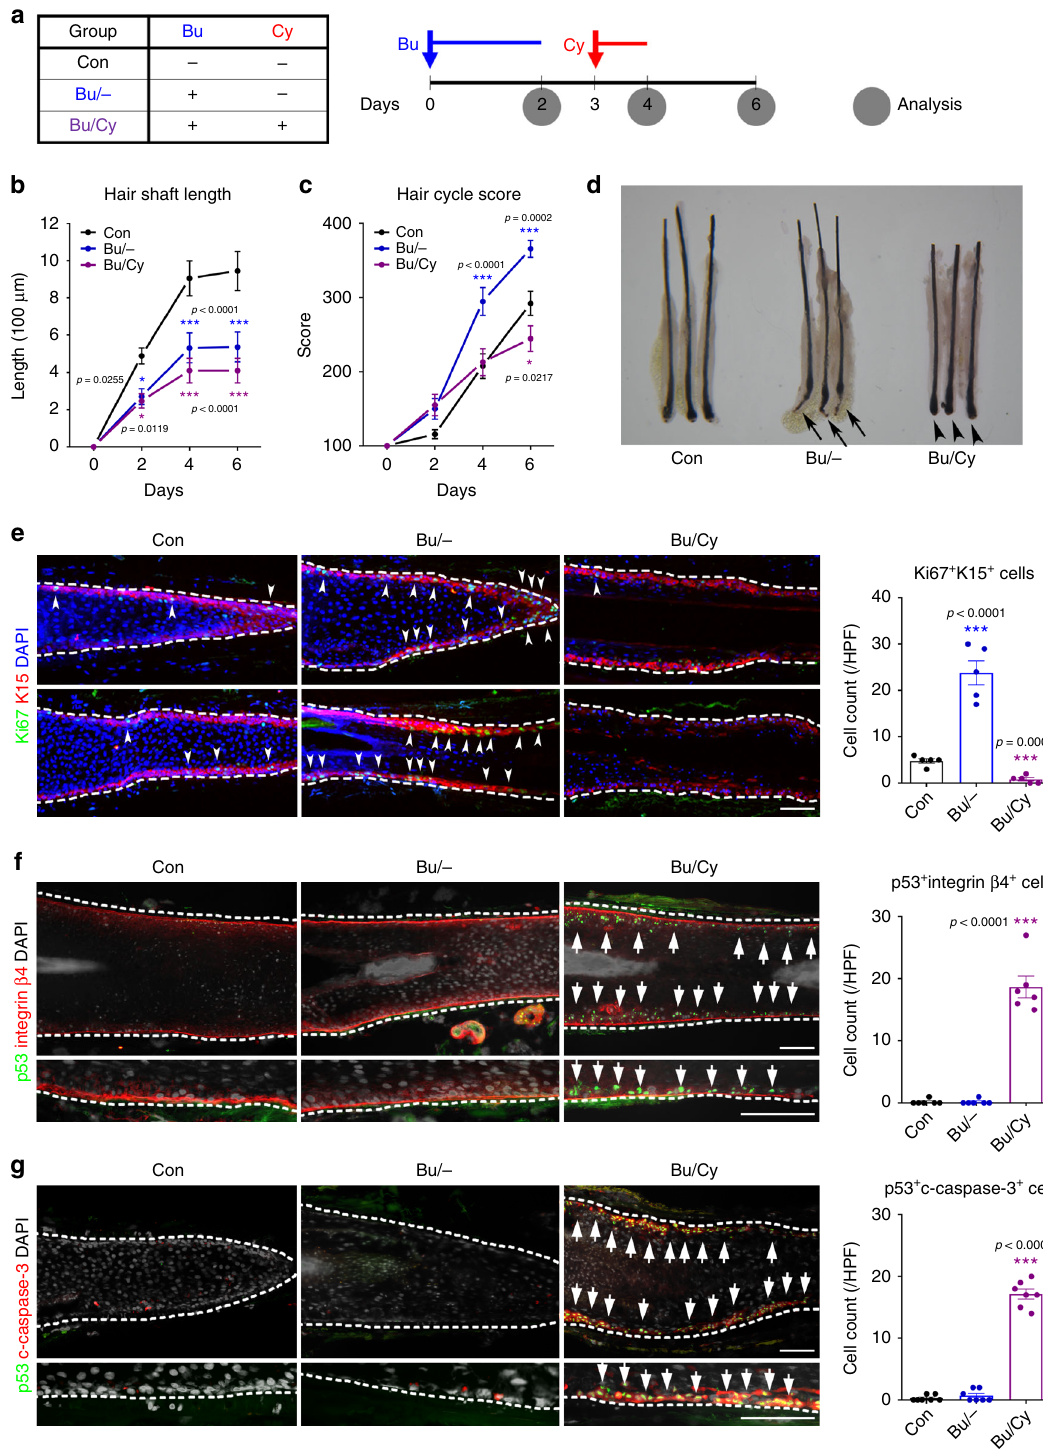
Global gene expression changes of in vivo HFSCs . To con- solidate the HFSC response in permanent CIA in humans, global gene expression changes were evaluated in in vivo HF xenografts after sequential Bu/Cy treatment. Using laser capture micro- dissection, HFSCs were obtained from the basal layer in the bulge and analyzed with RNA-seq (Supplementary Fig. 11) 38,39 . Based on hierarchical clustering (Fig. 8a), the upregulated genes after Bu or Bu/Cy treatment were selected for functional enrichment pathway analysis from the Reactome database 40 . Mitotic cell cycle